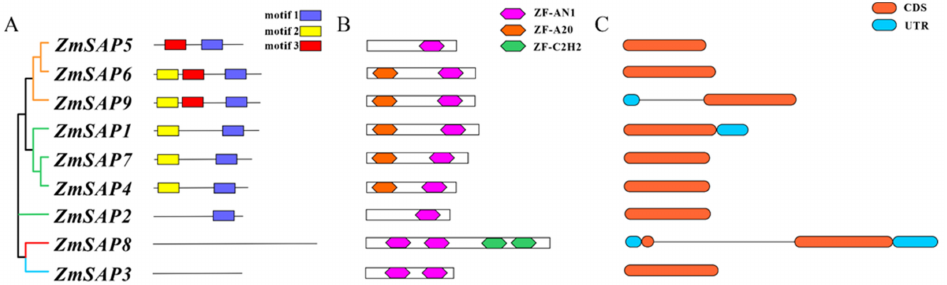
Figure 6. Phylogenetic and structural analysis of ZmSAPs members. Blue, red, green, and orange branches represent clade I to V, ( A ) motif structure of ZmSAPs , ( B ) protein domain of ZmSAPs, ( C ) gene structure of ZmSAPs .